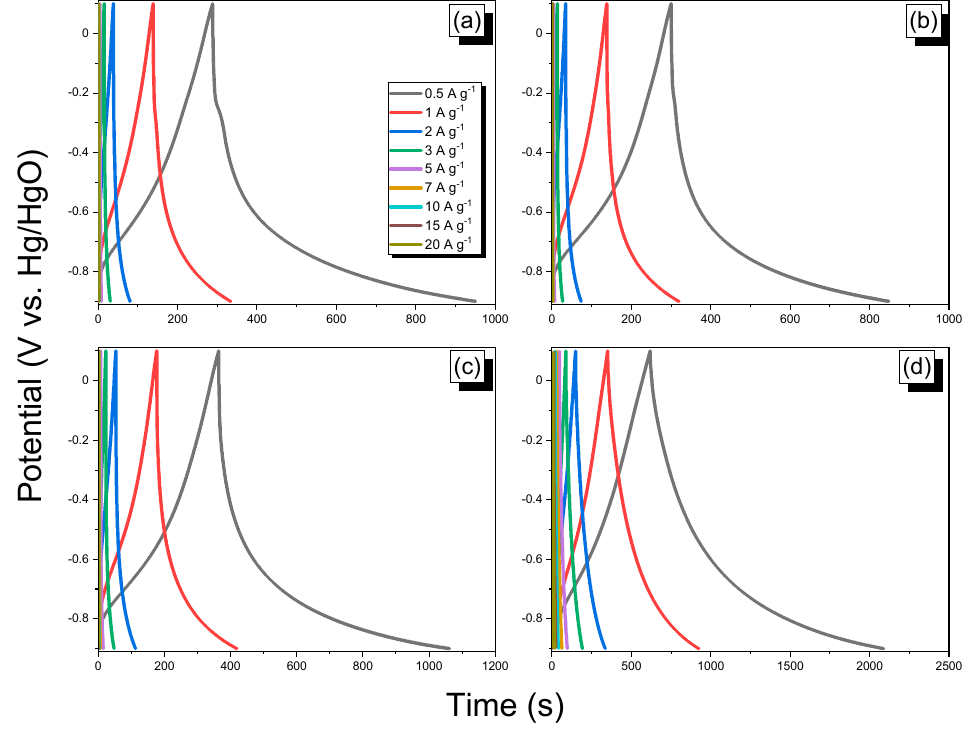
Figure 10. GCD performance of ( a ) P-AP-BZ POP, ( b ) PA-BZ POP/metal composite, ( c ) MPC, and ( d ) PCMC. Figure 11a displays the specific capacitances of all of the samples, determined from GCD curves using Equation (S1). The capacitance of the PCMC was excellent (735 F g –1 ) and highest among the tested samples (PA-BZ POP: 331 F g –1 ; PA-BZ POP/metal